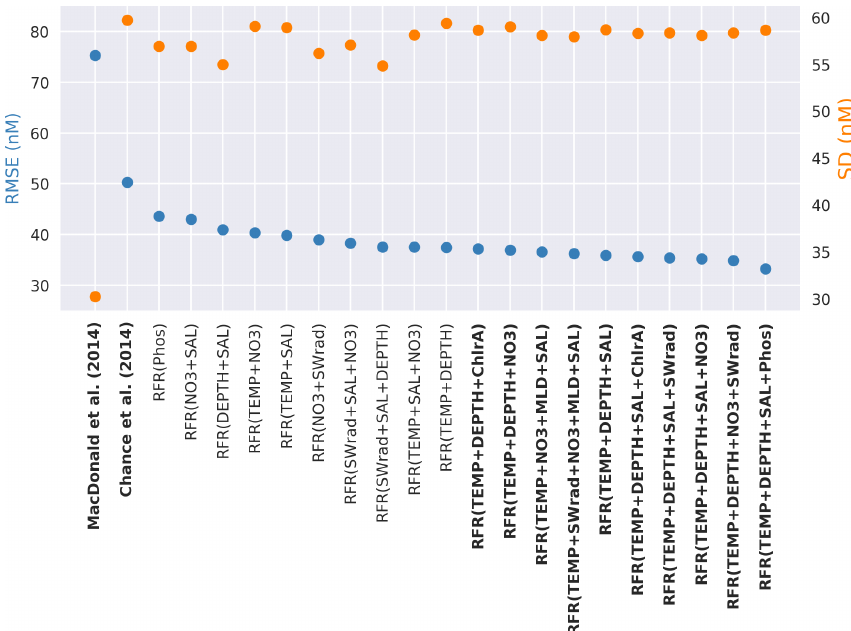
Figure 2. Random forest regression (RFR) model performance (root mean square error (RMSE), blue) against the withheld data for the top 20 models on the left-hand y axis, along with values from the parameterisations from Chance et al. (2014) and MacDonald et al. (2014). The right-hand y axis is standard deviation of the prediction for the withheld data (orange). The top 10 performing models and the two exiting parameterisations considered here (Chance et al., 2014; MacDonald et al., 2014) are shown in bold. Parameterisations are ordered by their RMSE. Abbreviations are given in Table